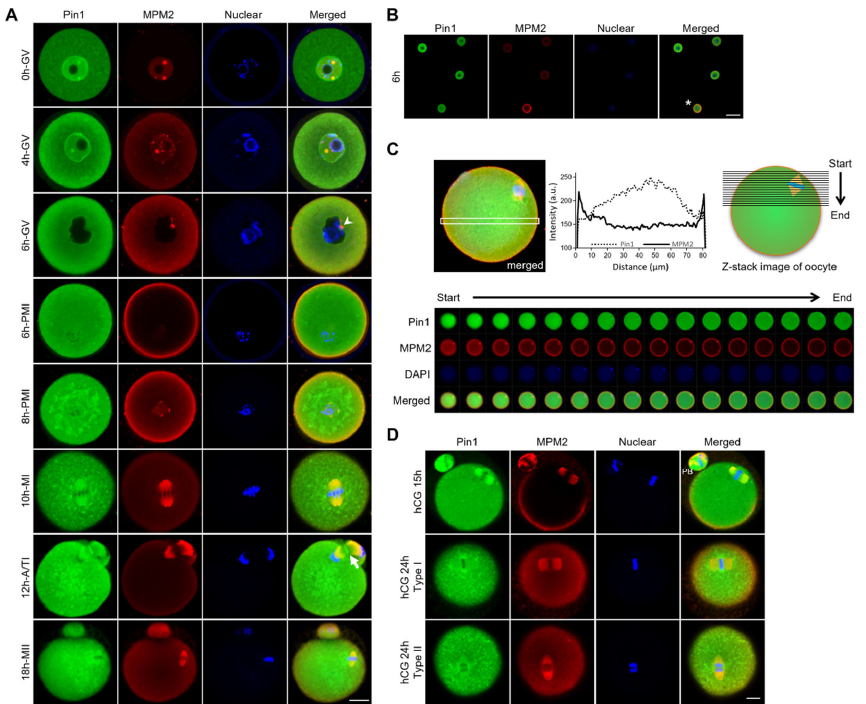
Figure 2. Pin1 and anti ‐ MPM2 ‐ reactive phospho ‐ mitotic proteins are dynamically localized during meiotic maturation. ( A ) Localization of Pin1 and phospho ‐ proteins detected using anti ‐ MPM2 antibody at different stages of oocytes collected at 0, 4, 6, 8, 10, 12, and 18 h after the start of in vitro maturation. The panels show typical localization patterns at germinal vesicle (GV), pro ‐ metaphase I (PMI), metaphase I (MI), anaphase/telophase I (A/TI), and metaphase (MII) stages. Arrowheads indicate distortion of the nuclear membrane (6 h GV), and arrows indicate localization of Pin1 in the midbody at A/TI (12 h A/TI). Scale bar, 20 μ m. ( B ) Comparison of the fluorescence intensities of Pin1 and anti ‐ MPM2 ‐ reactive phospho ‐ mitotic proteins in the cytoplasm between GV and immediately after germinal vesicle breakdown (GVBD). The panels show oocytes at 6 h after the start of culture; four oocytes are shown at low magnification. The upper three oocytes are in the GV stage, and one oocyte (indicated with an asterisk) has just after GVBD. Scale bar, 100 μ m. ( C ) Comparison of the localization of anti ‐ MPM2 ‐ reactive phospho ‐ mitotic proteins and Pin1 in the M phase. The graph shows the fluorescence intensity of Pin1 and MPM2 in the white ‐ framed area of the merged image. The panels show continuous photographs obtained using the Z ‐ stack analysis from the cell surface layer toward the cell center in MI oocytes. ( D ) Changes in the localization of Pin1 and MPM2 antigens during the aging of oocytes. The panels show typical localization patterns in mature oocytes collected from oviducts at 15 and 24 h after hCG injection. Green, red, and blue show Pin1, anti ‐ MPM2 ‐ reactive phospho ‐ mitotic proteins, and nuclei, respectively. Scale bar, 20 μ m. PB, polar body.